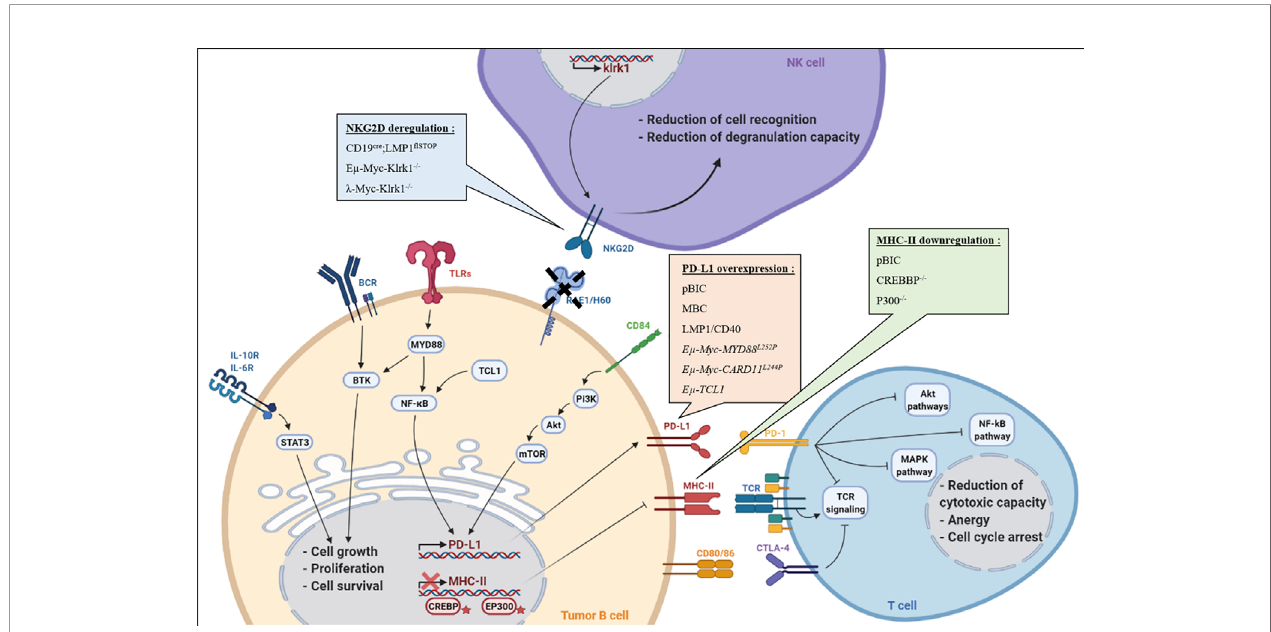
FIGURE 1 | B/T/NK cells in the immune escape context. Representation of different mechanisms exploited by tumor B-cell lymphomas to escape immune control during lymphomagenesis in each presented transgenic mouse models: (i) overexpression of PD-L1 associated with MHC-II downregulation to induce T-cell anergy, (ii) Reduction of RAE1/H60 expression to induce NK cells tolerance, (iii) CTLA-4 expressed by T-cells is targeted by lymphoma B cells, leading to T-cell